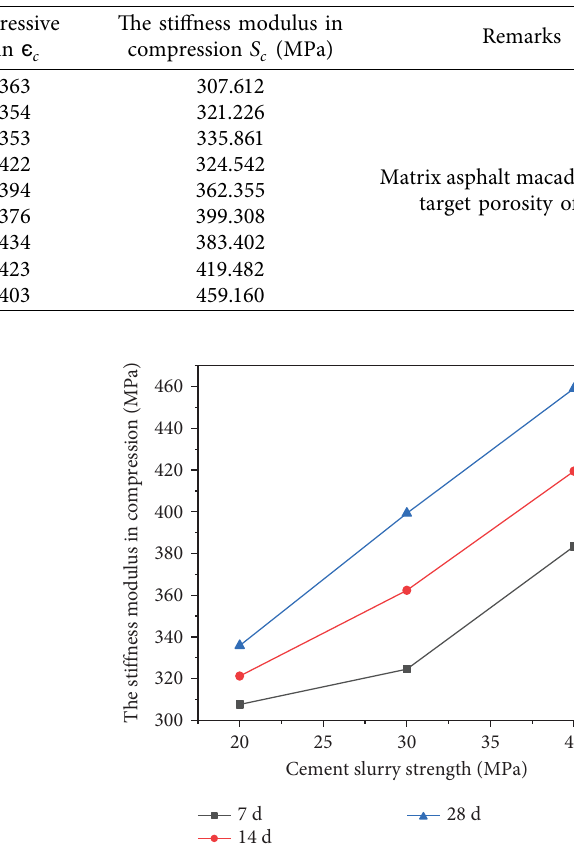
Figure 10: Variation curve of the stifness modulus in compression with cement slurry